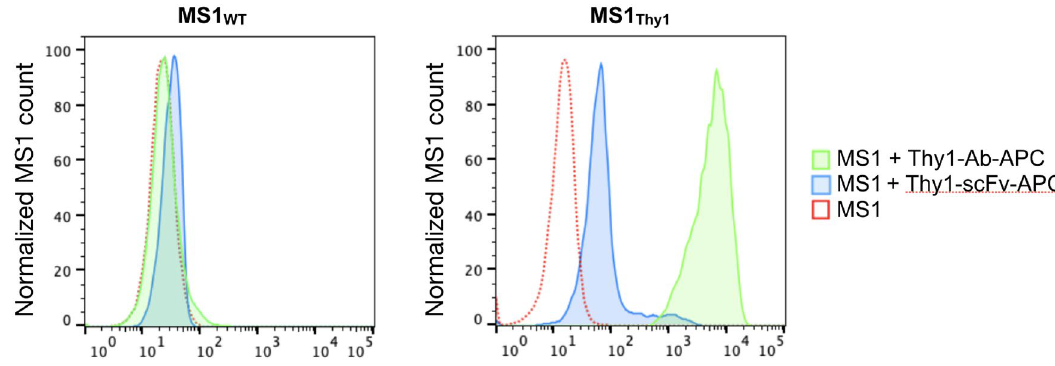
Figure 7. Binding efficiency of Thy1-scFv to MS1